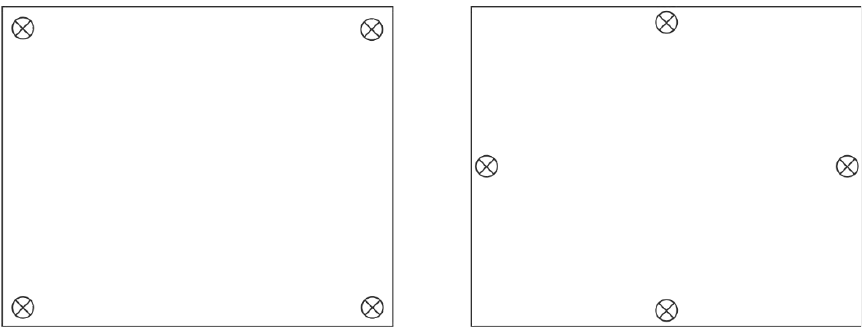
Fig. 2 Used configurations of sensors for vibration measurement: Configuration 1 used for BS 404 and BS 405 tests (left); Configuration 2 used for BS 406 to BS 408 tests (right).